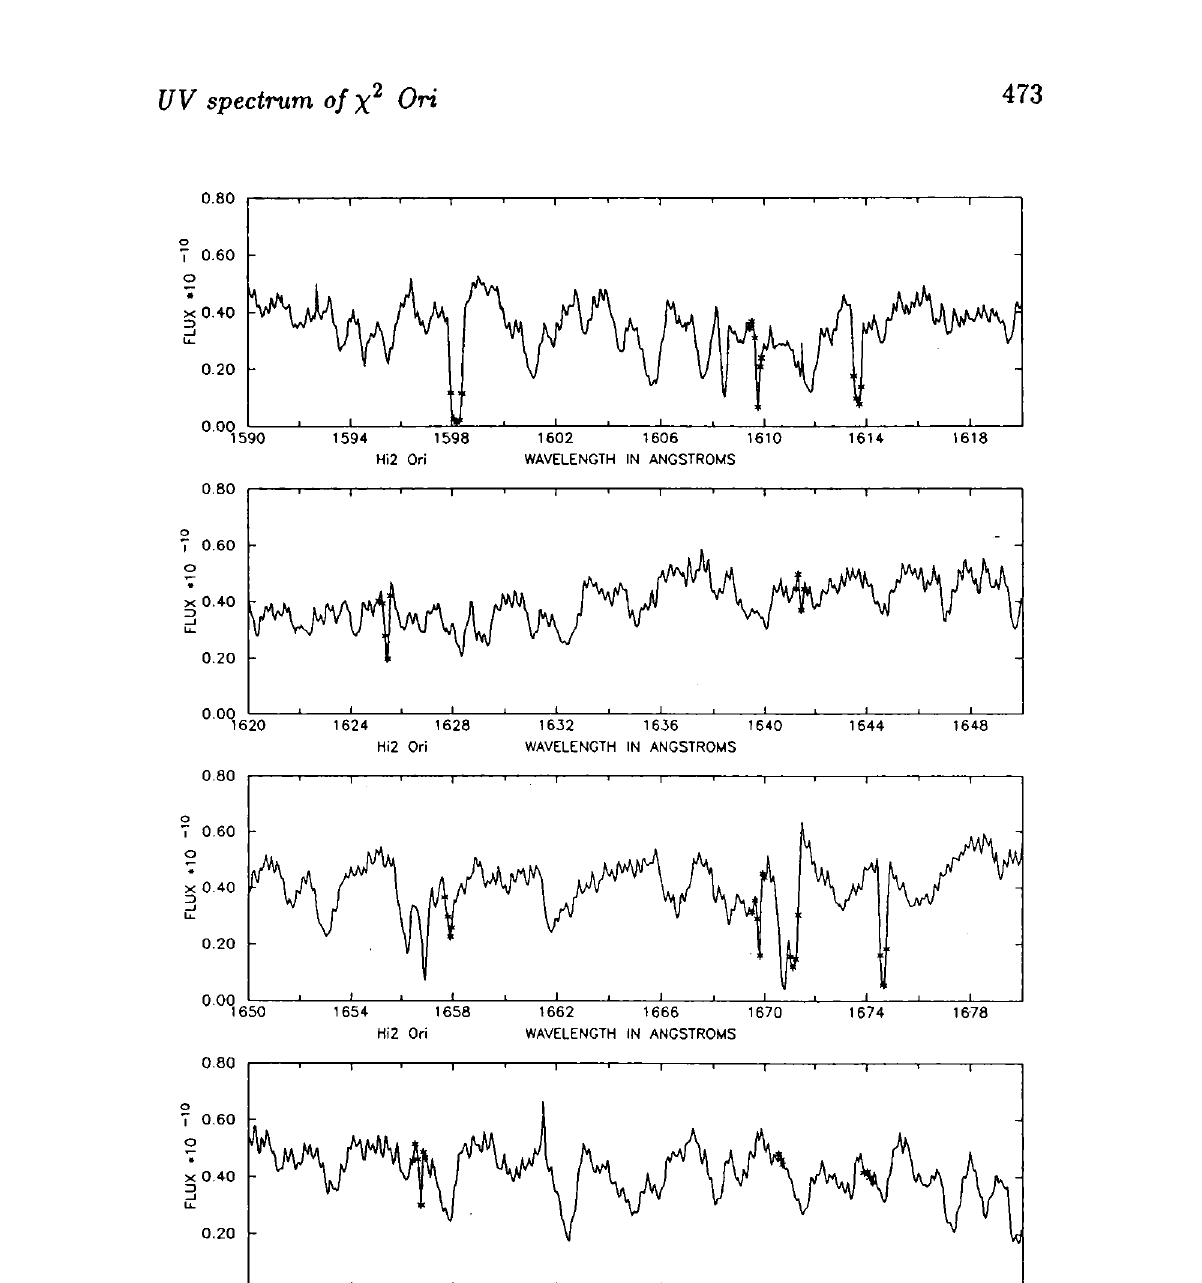
Fig. 7. SWP spectrum of Ori for spectral region 1590-1710